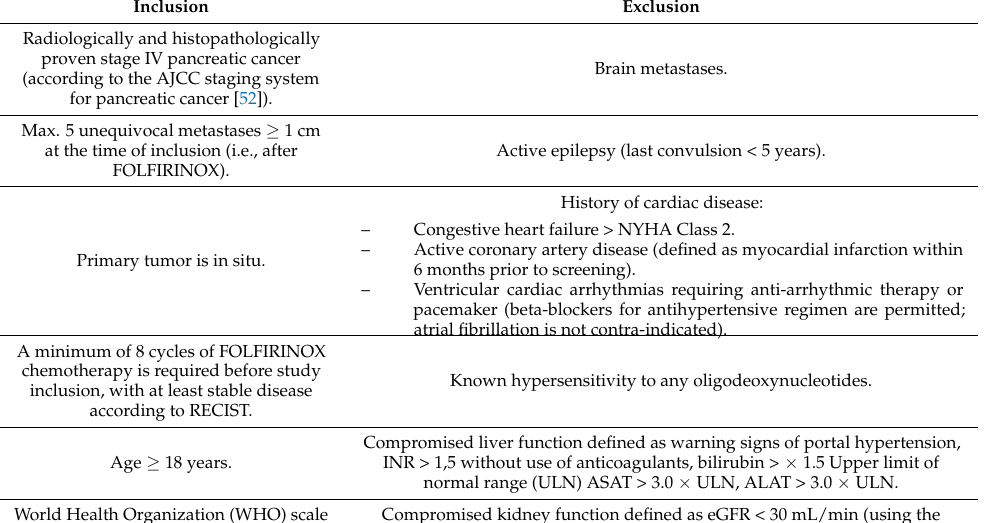
Table 1. In- and exclusion criteria